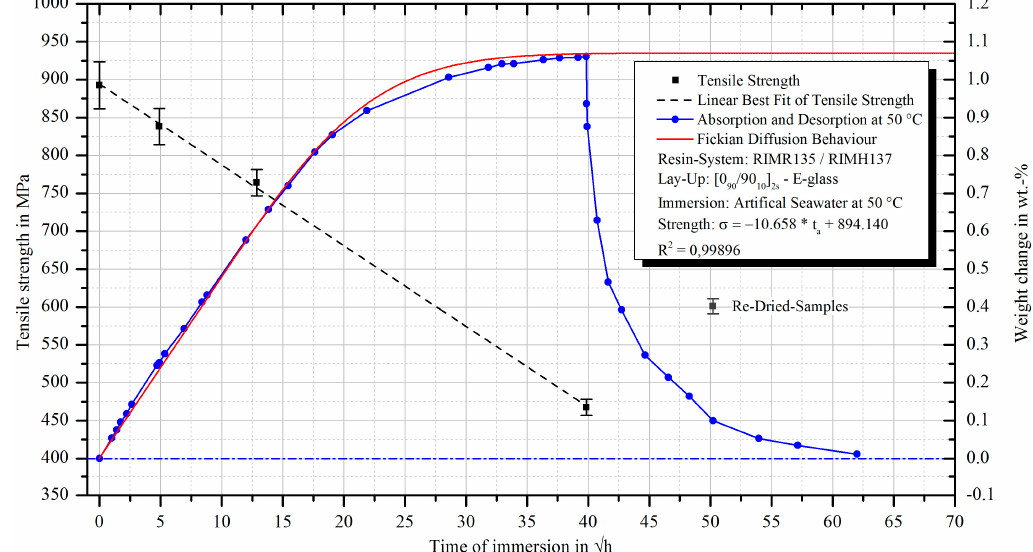
Figure 8. Tensile strength (black) in dependence of the immersion duration and amount of absorbed water at 50 °C (blue). Additionally, the effect of desorption for partial recovery of the tensile strength and the theoretical diffusion behaviour according to (2) is depicted (red).